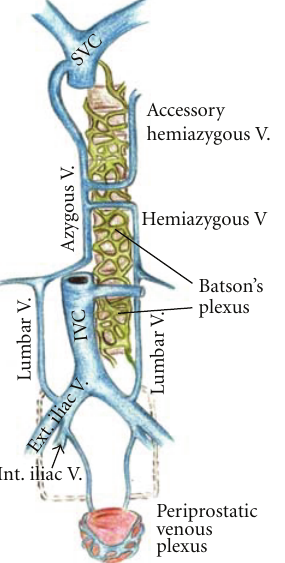
Figure 2: The periprostatic or paravaginal plexus drains primarily to the internal iliac veins via the vesical veins to reach the inferior vena cava and eventually the pulmonary circulation. Alternatively, this plexus communicates with Batson’s vertebral plexus which, in turn, reaches the pulmonary circulation via either the azygous system or the superior vena cava. (This figure is the author’s illus-